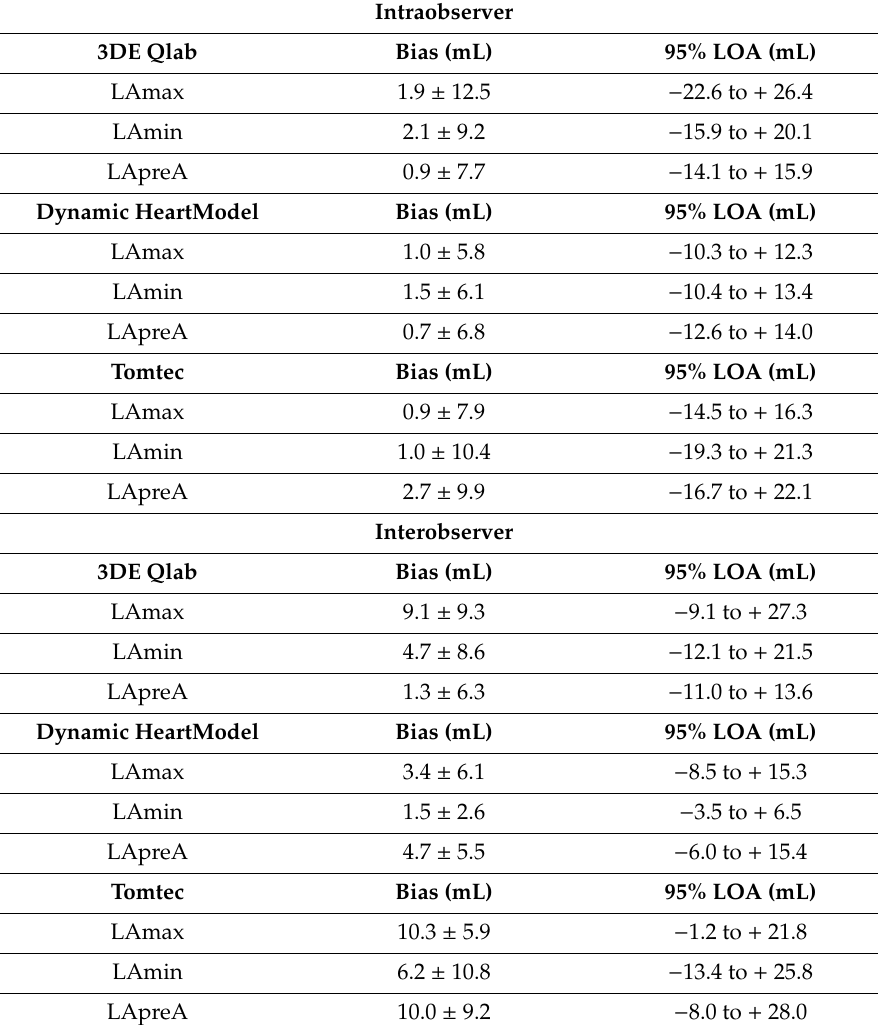
Table 3. Bland–Altman bias and limits of agreement intra- and